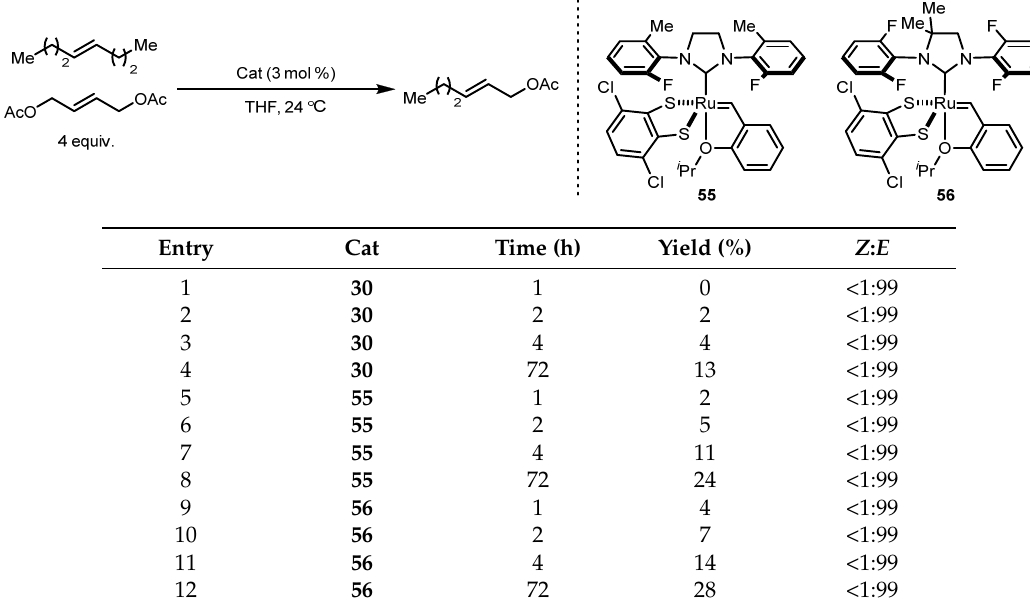
Figure 15. Stereochemical model illustrating the steric environment governing stereoretentive OM. Table 20. Effects of N -aryl ortho -substituents on the reactivity of stereoretentive olefin methathesis (OM).